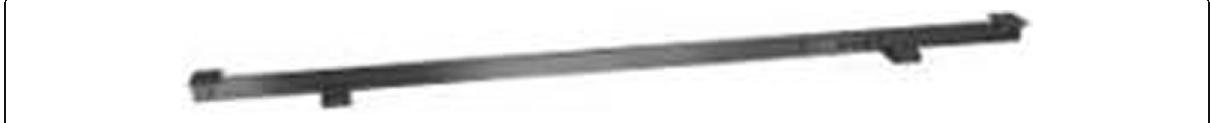
Fig. 4 A calibration point with a reflective